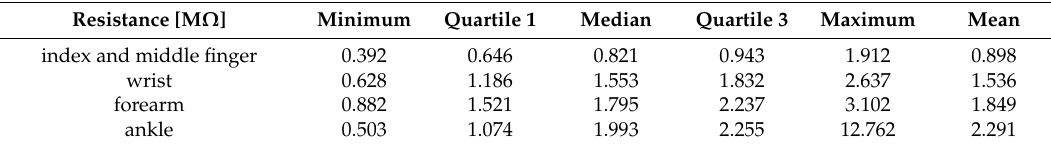
Table 3. Statistical analysis of skin resistance depending on the sensor